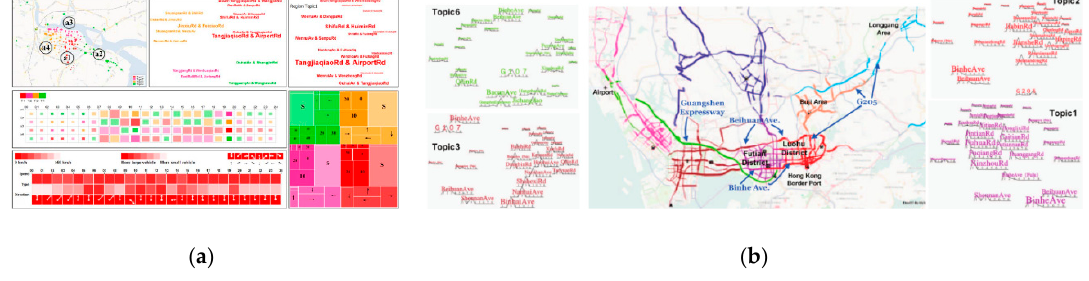
Figure 6. Word-cloud views of trajectories: ( a ) traffic areas indicated by word clouds [23]; and ( b ) taxi-topic visualization [22].